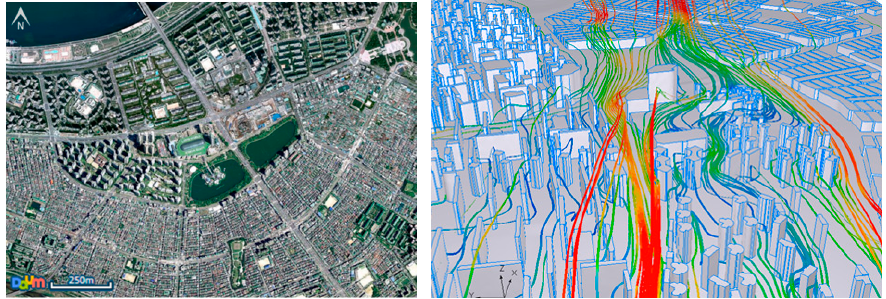
Figure 8. Computation domain around the Lotte World Tower ( left ); and the pedestrian-level wind flow streamlines ( right ).